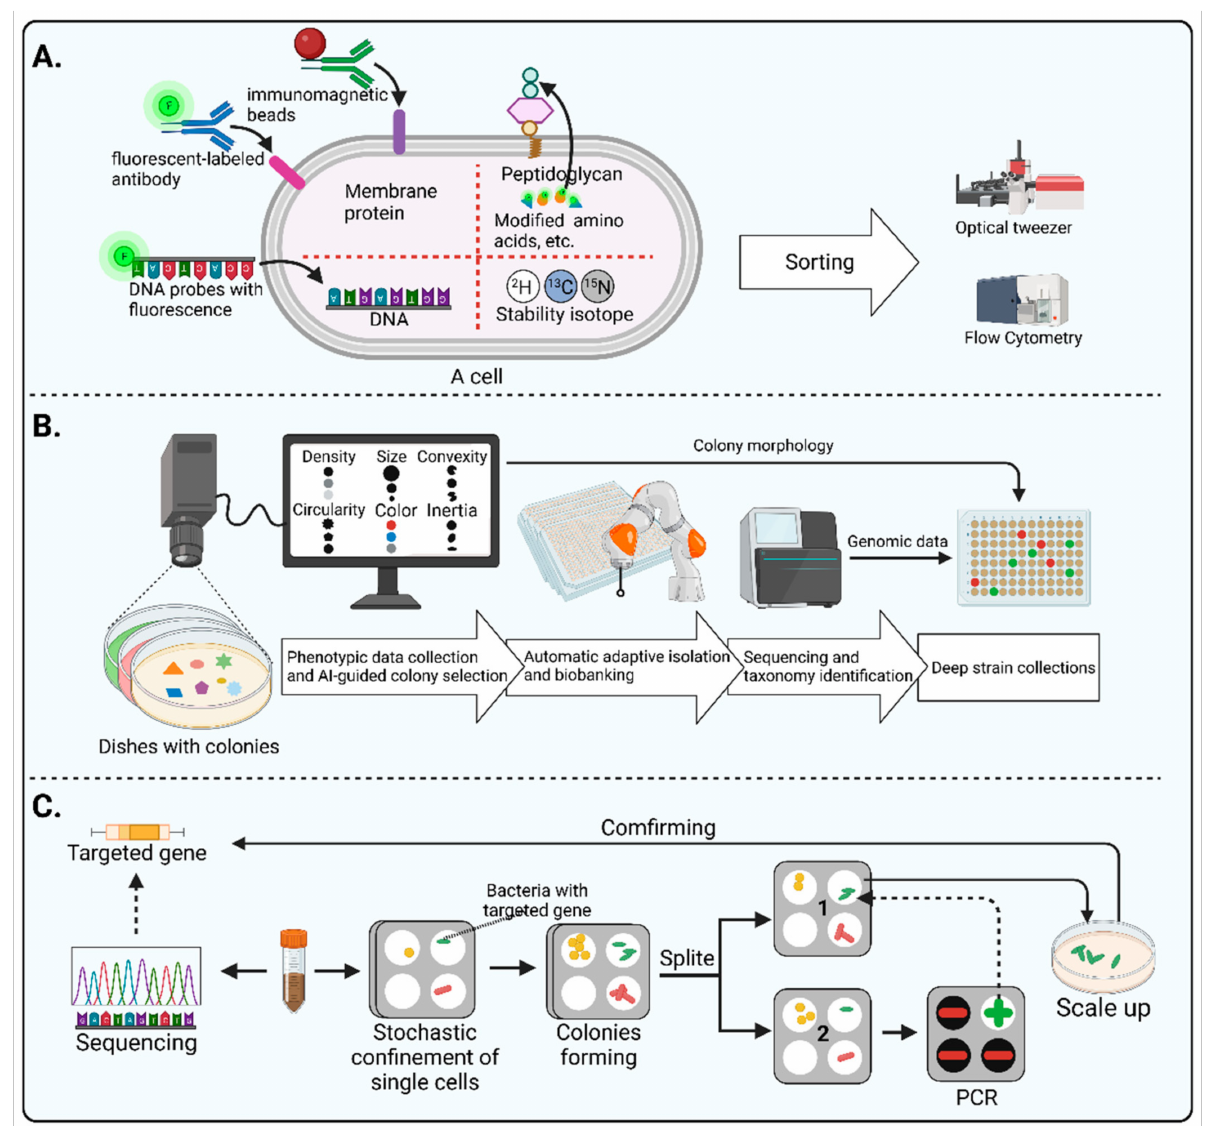
Figure 4. The summary of innovative approaches to isolate microorganisms. ( A ) Labeling-based method for cell sorting including Live-FISH, metabolites labeling, antibody engineering, and Raman- activated microbial cell sorting (RACS); ( B ) Automated Microbiome Imaging and Isolation (CAMII); ( C ) Gene-targeted microfluidic isolation. The 1 and 2 in the Figure 4C represent the top and bottom halves of the chip. Created with